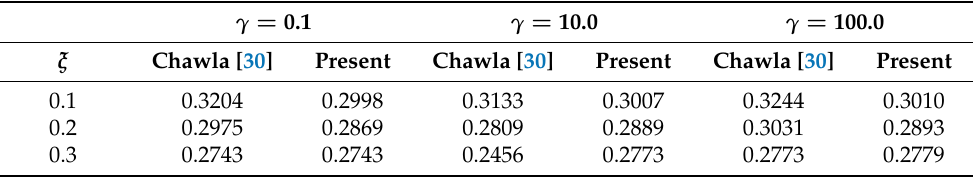
Table 2. The numerical results of skinfriction for various choices of magnetic force parameter at the leading edge. γ = 0.1 γ = 10.0 γ = 100.0 ξ Chawla